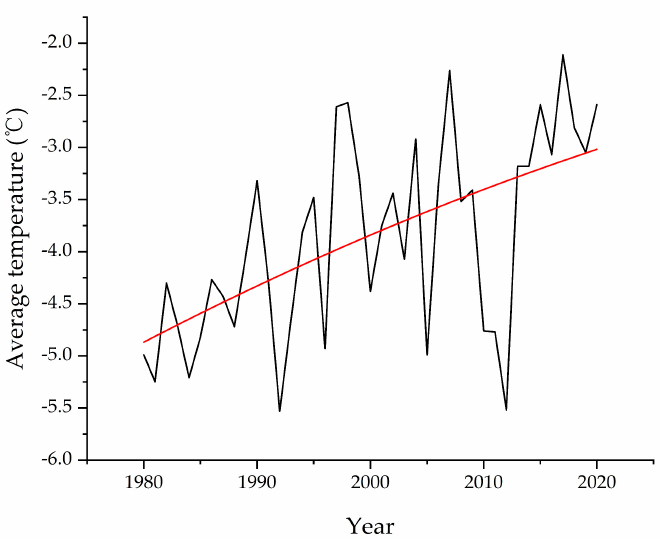
Figure 3. Weather data collected from NOAA’s stations for Lake Khovsgol from 1980–2020. Table 1. The Sentinl-2 optical images used in this paper.